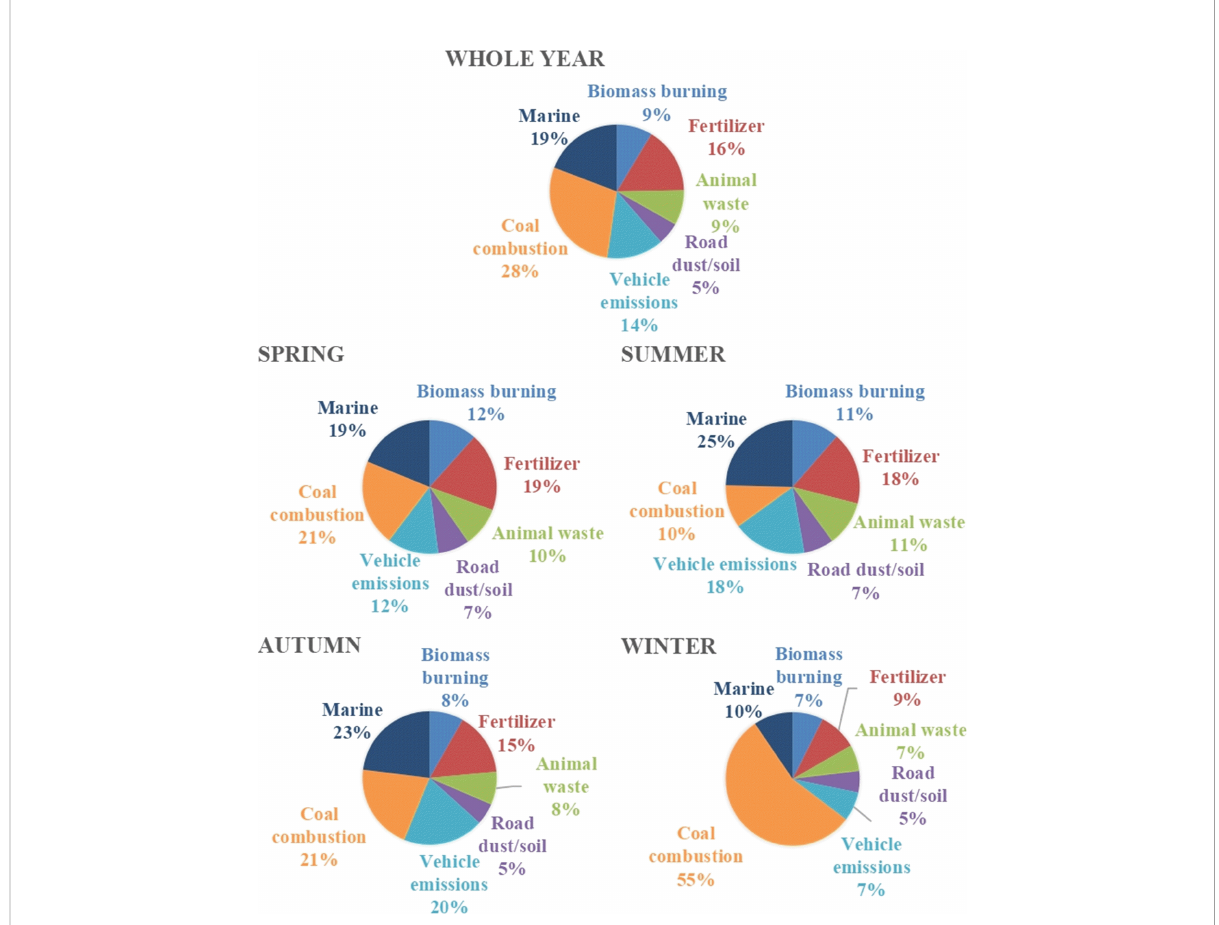
FIGURE 4 Source apportion via bi-nitrogen isotopes of aerosol nitrate and ammonium at the Qianliyan